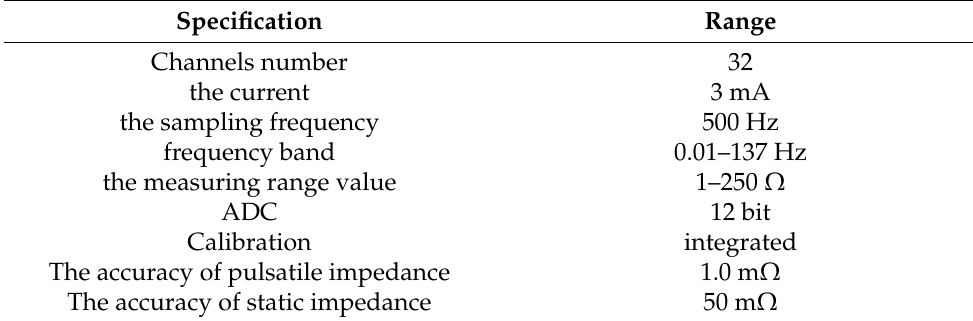
Table 3. The technical specification of the bio-impedance system.